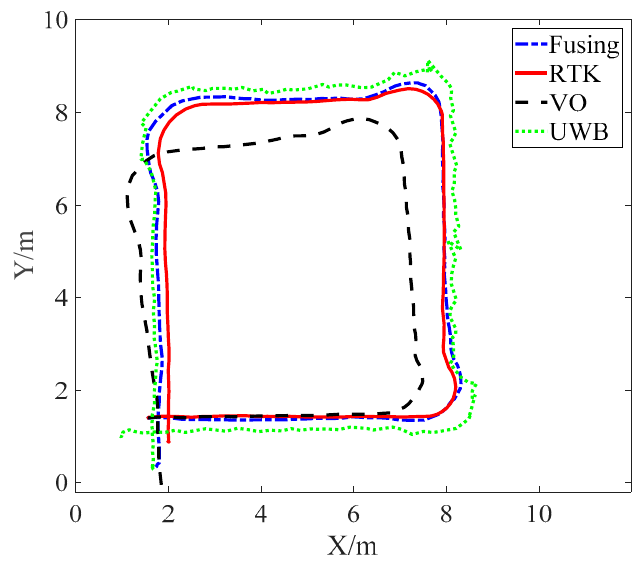
Figure 9. The comparison of trajectories in the X–Y plane.